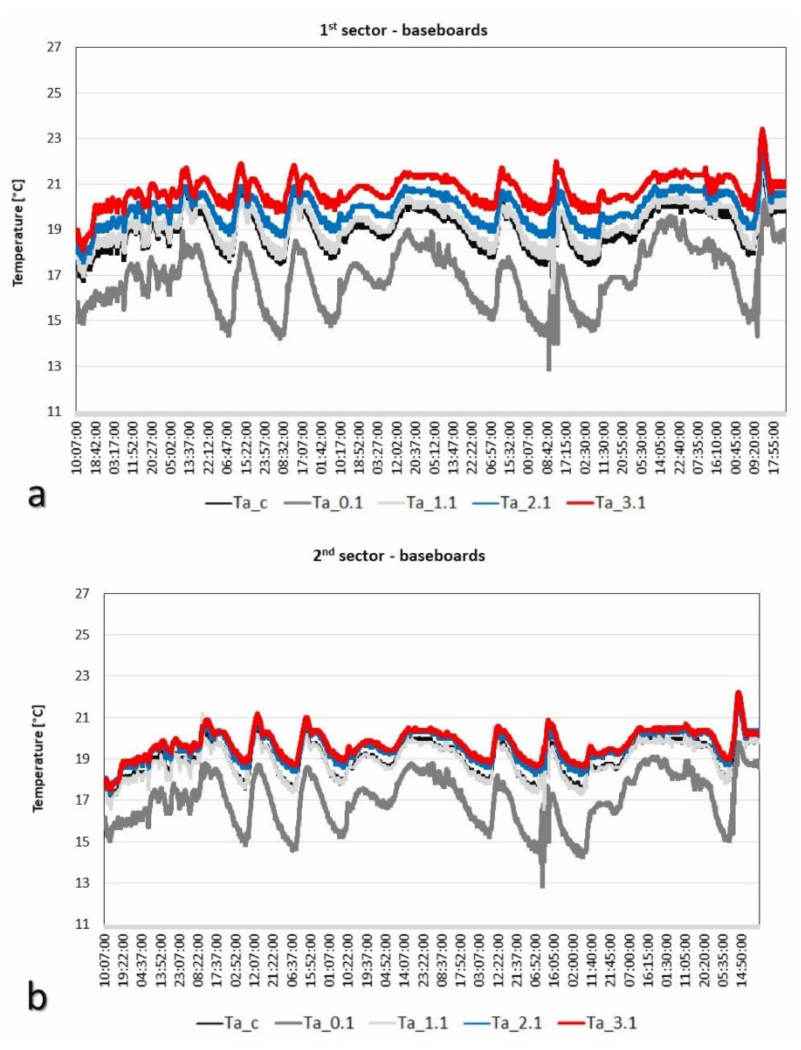
Figure 7. Air temperature at different heights with baseboards: ( a ) 1st sector, ( b ) 2nd